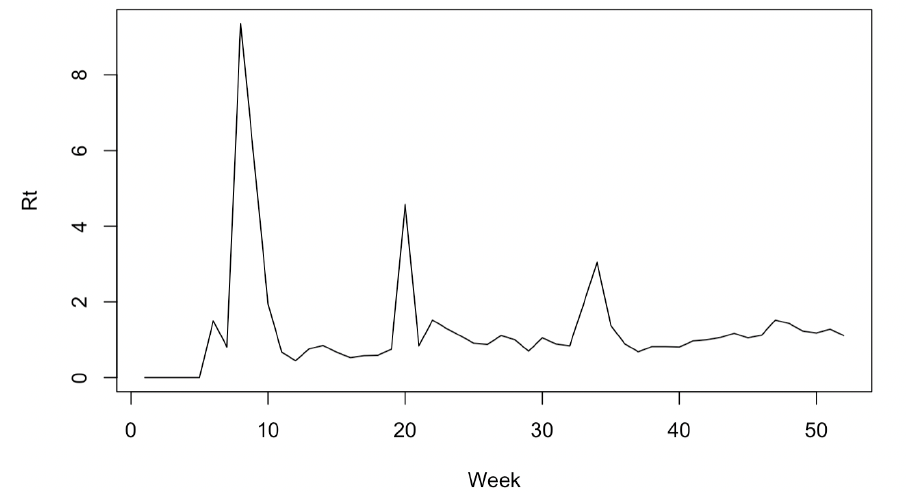
Figure 2. The Korea R t in 2020 by